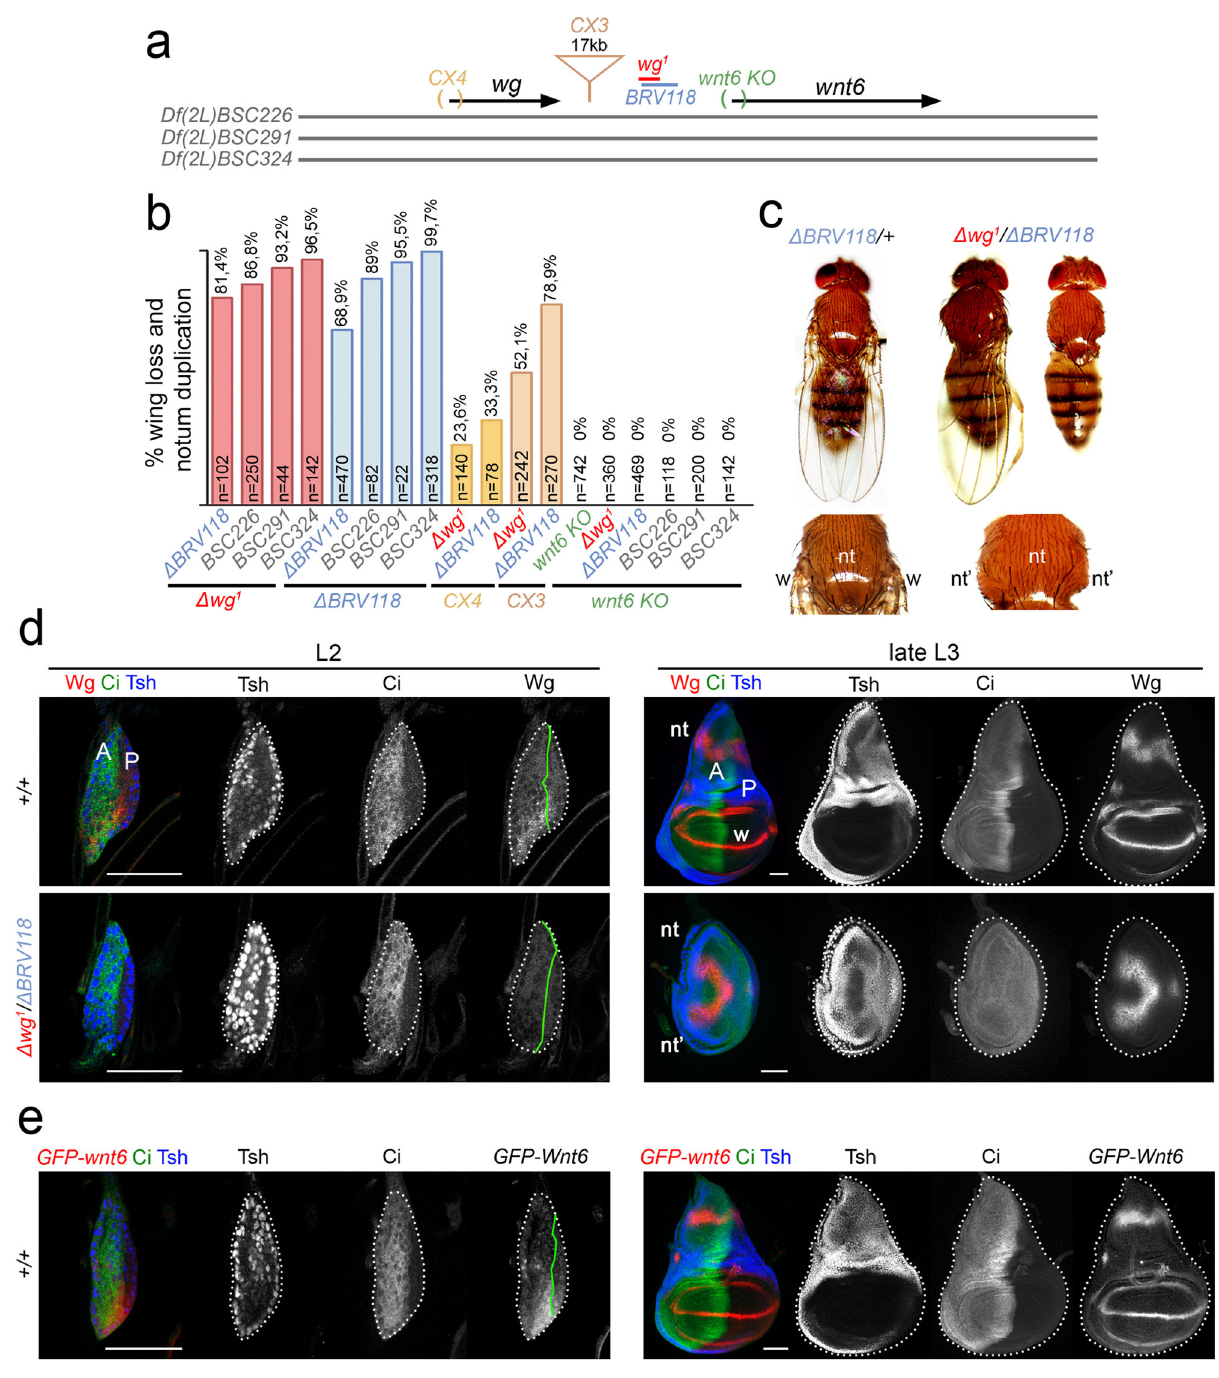
Fig. 1 | A genomic region required to drive early expression of Wg and wing speci fi cation. a Cartoon depicting the genomic location of the wg 1 /BRV118 enhancer between the wg and the wnt6 genes and the de fi ciencies and muta- tions affecting these elements. b Histogram showing the percentage of wing- less fl ies with duplicated nota of the indicated genotypes. The number of scored heminota are shown. c Examples of notum duplications in adult fl ies of the indicated genotypes. d , e Second (L2) and late third (L3) instar wing discs